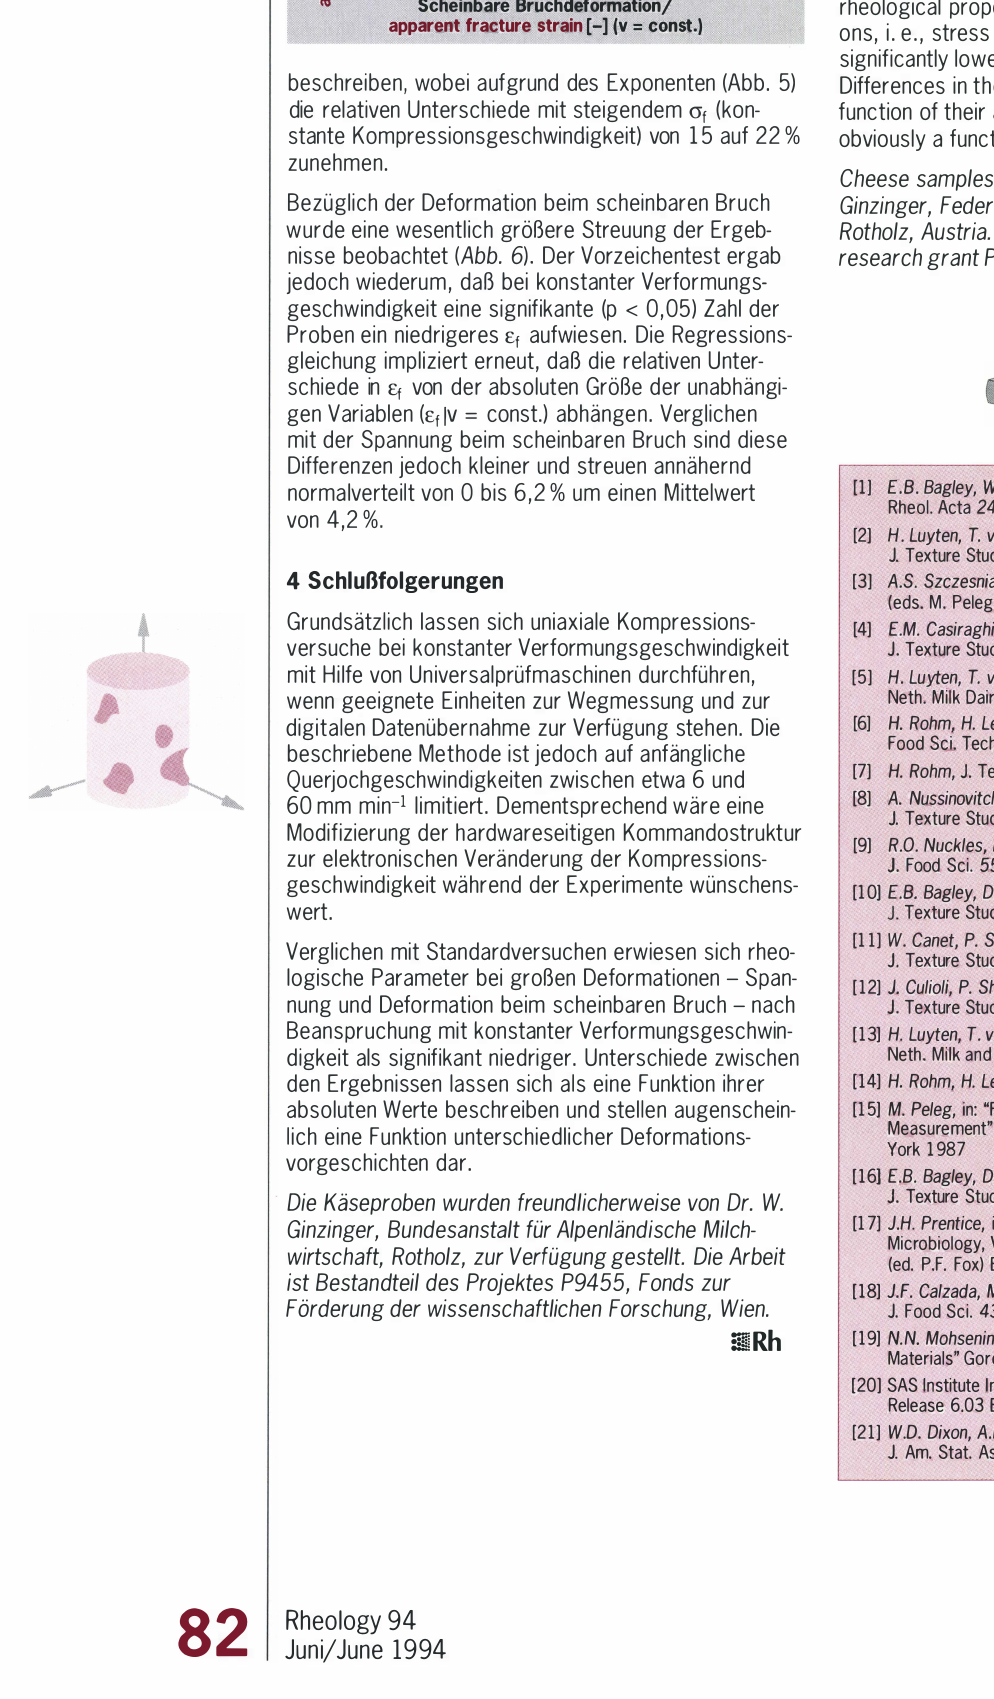
- - - ·-+ 1.4 1.6 Scheinbare